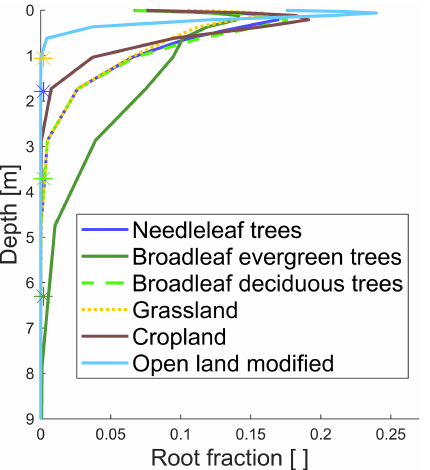
Figure A6. Example of the calculation of the β t factor with the 10% modification. Shown are five soil layers, with the fraction of the roots in these layers in brown and the wilting factor in blue. On the bottom, the calculation of β t for this particular example with the 10% modification ( β 10PER t ) and the default calculation in CLM4.5 ( β DFLT t ), assuming the roots not shown have a wilting factor of 0. The root fractions eventually used to calculate β 10PER t are shaded in